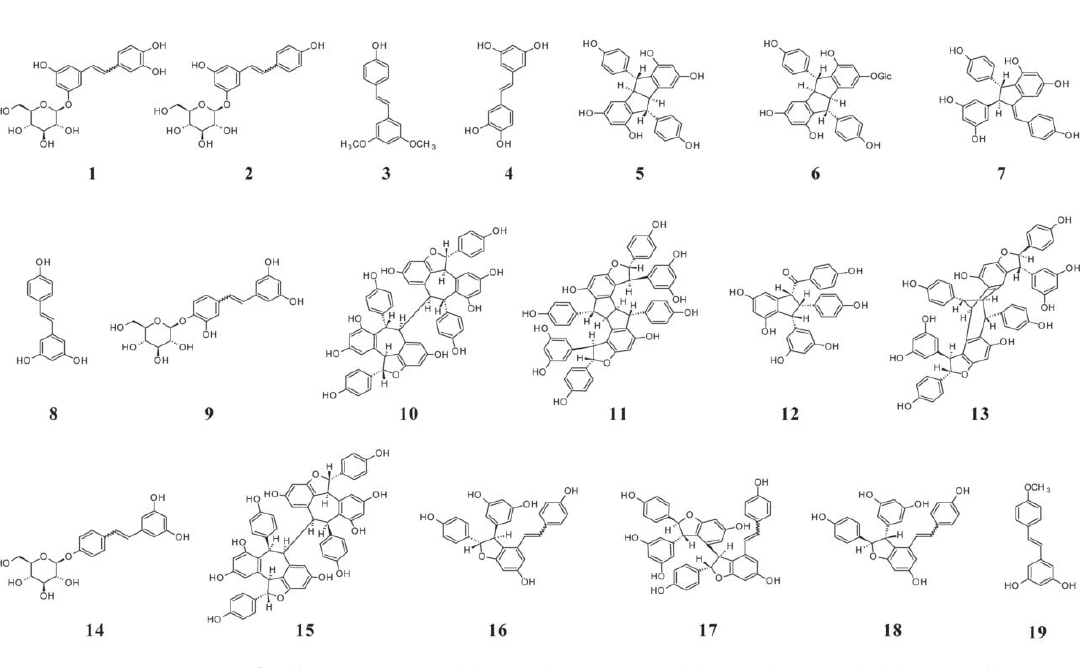
Figure 2. Structures of stilbenes in grape. ( 1 ) Z - and E -astringin; ( 2 ) Z - and E -piceid; ( 3 ) pterostilbene (3,5-dimethoxy-4 (cid:48) -hydroxystilbene); ( 4 ) piceatannol; ( 5 ) pallidol; ( 6 ) pallidol-3- O -glucoside; ( 7 ) parthenocissin A; ( 8 ) trans-resveratrol; ( 9 ) resveratroloside; ( 10 ) hopeaphenol; ( 11 ) ampelopsin H; ( 12 ) caraphenol B; ( 13 ) vaticanol C isomer; ( 14 ) resveratrol-4 (cid:48) - O - β - d -glucopyranoside; ( 15 ) isohopeaphenol; ( 16 ) E - and Z - ε -viniferin; ( 17 ) E - and Z -miyabenol C; (18) E - and Z- δ -viniferin; ( 19 ) trans -resveratrol-4 (cid:48) - methyl ether